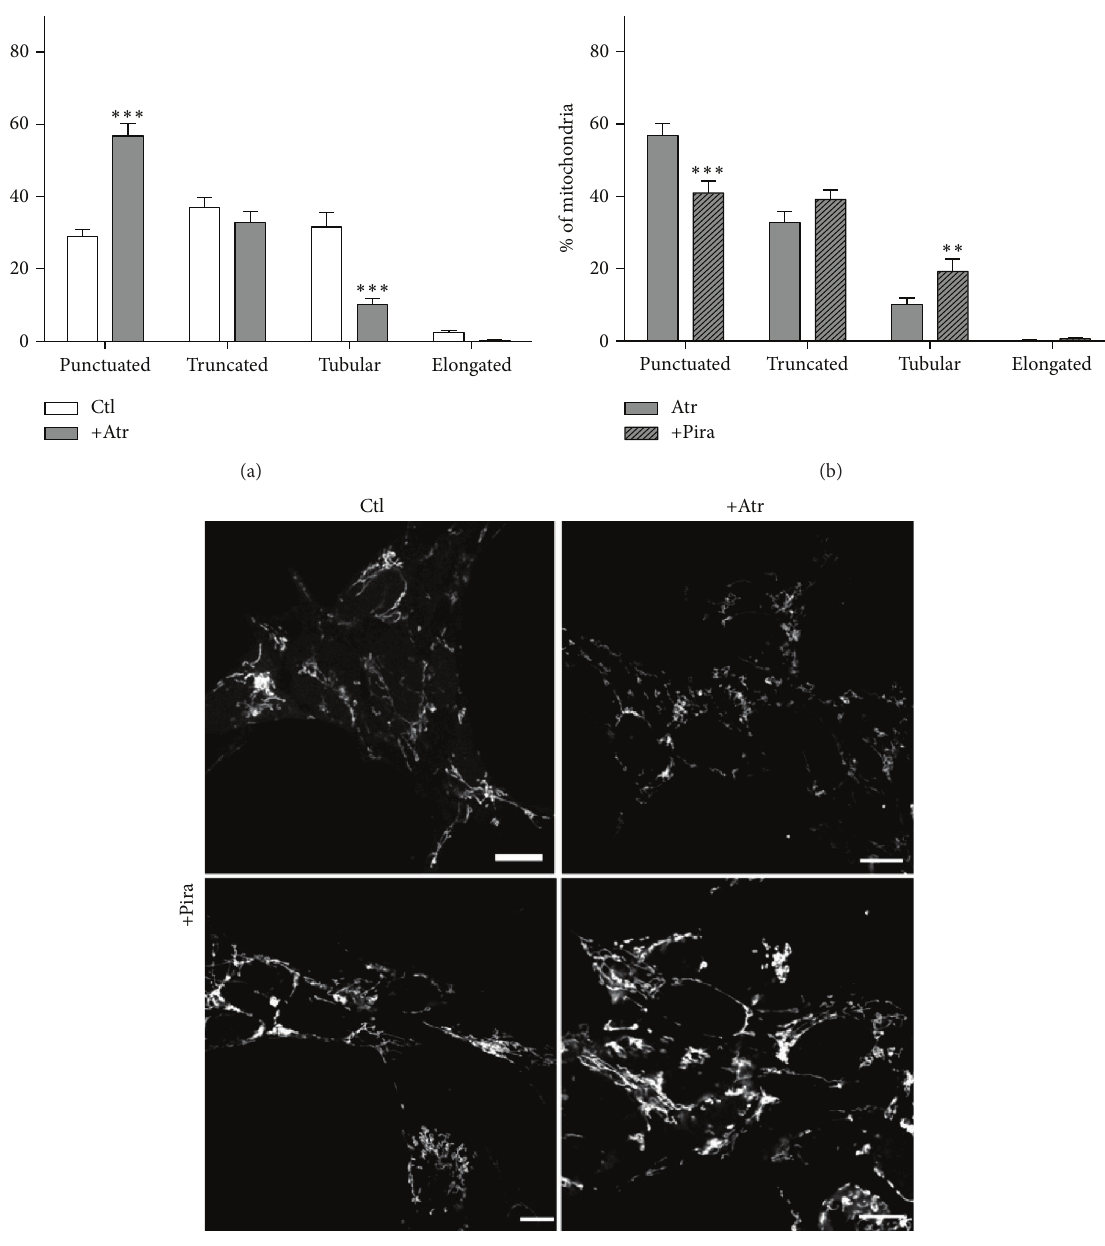
Figure 8: The mPTP inductor atractyloside (Atr) induces mitochondrial fragmentation. (a) Atr induces mitochondrial fragmentation. Cells treated with Atr exhibit more punctuated and less tubular mitochondria. (b) Piracetam (Pira) is able to ameliorate these changes in mitochondrial dynamics. SH-SY5Y Ctl cells were incubated with piracetam (1mM) for 3 hours, Atr was added for the last 2.5 hours, and cells were stained and fixed for analysis of mitochondrial dynamics. (c) Representative pictures of SH-SY5Y cells treated with media as control, atractyloside (Atr, 100 𝜇 M), and/or piracetam (Pira, 1mM). Scale bar represents 10 𝜇 m. Data are represented as mean ± SEM; Two-Way ANOVA with Bonferroni’s posttest ( ∗∗ 𝑝 < 0.01 , ∗∗∗ 𝑝 < 0.001 compared to untreated control cells or Atr treated cells, resp.); 𝑛 = 5